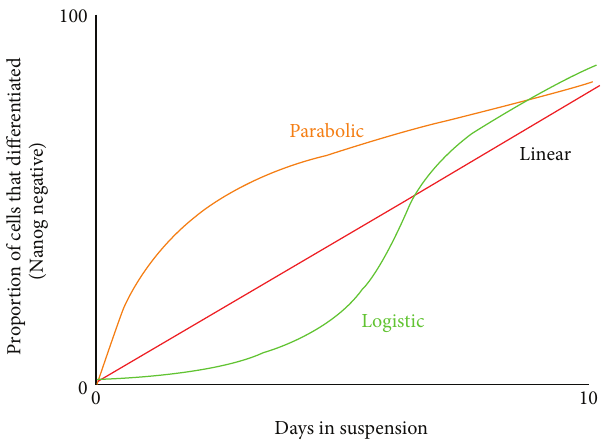
Figure 4: This theoretical curve fitting graph reveals the type of data that would come from plotting the number of cells that have differentiated over time. Data like those found in Figure 3 could be used to generate a graph such as this. Because differentiation is regulated by inductive signals, we predict it is modeled by a logistic curve; the lag period caused by upregulation of signals, the growth period caused by high signaling activity, and plateau caused by downregulation of signals.